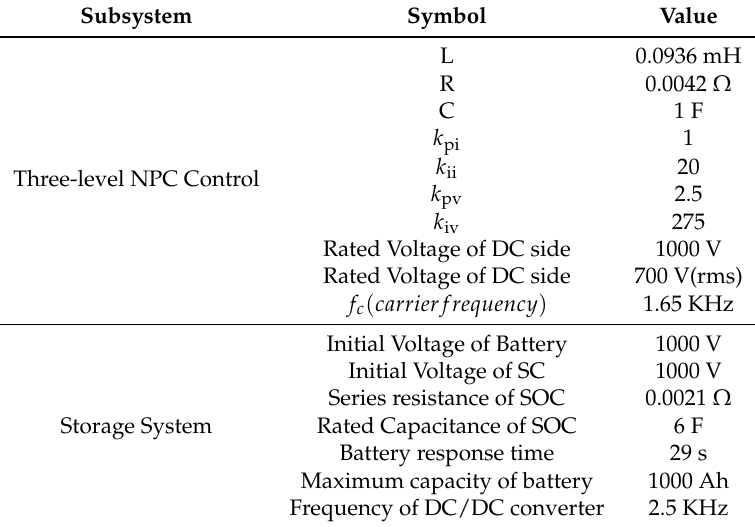
Table 1. Parameters of control system.